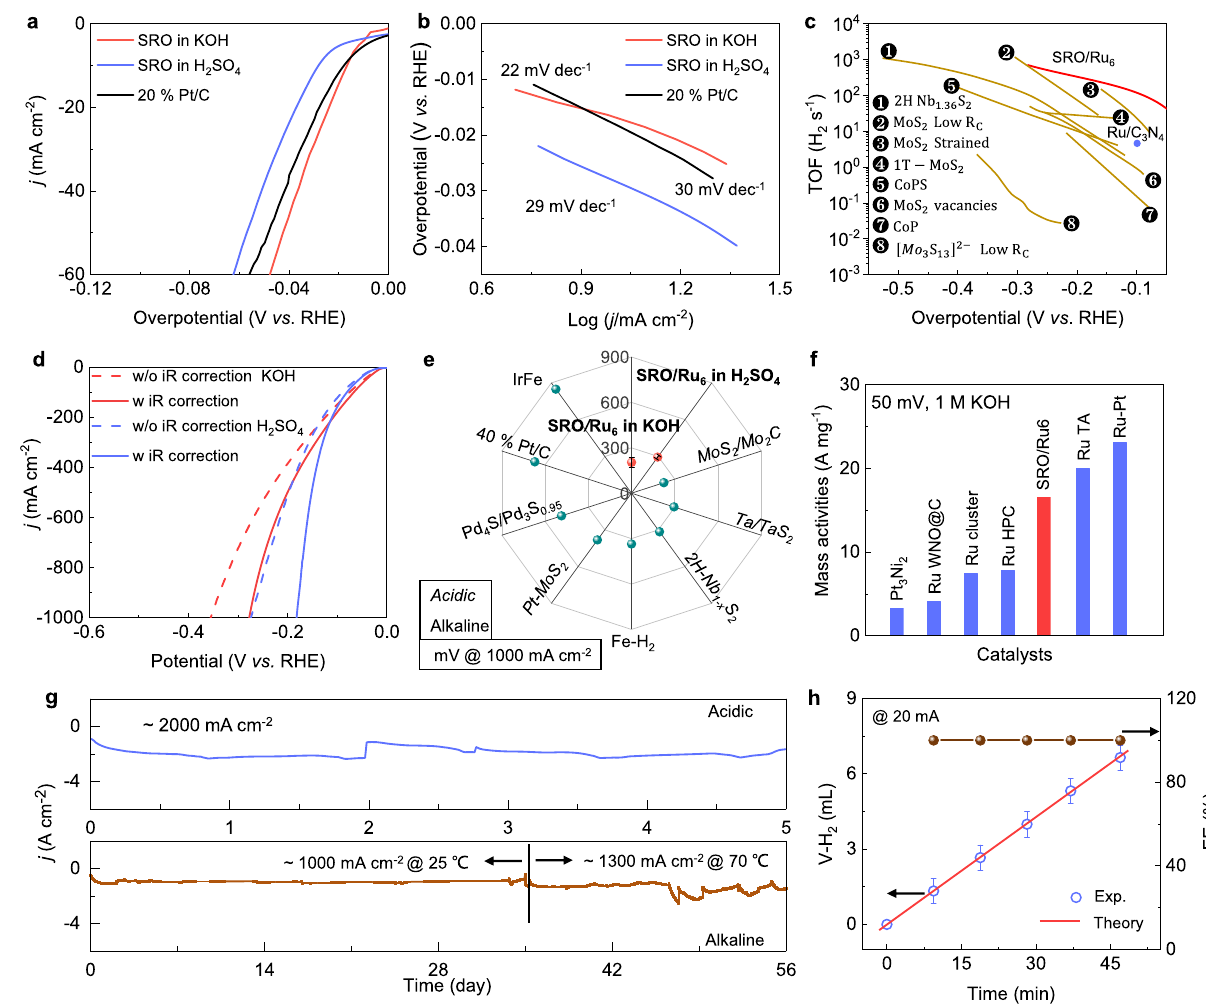
Fig. 2 | HER performance of SRO single crystal catalysts. a HER polarization curvesand b thecorrespondingTafelslopesofSROcatalystin0.5MH 2 SO 4 and1M KOH electrolytes. The LSV curve of Pt/C in 0.5M H 2 SO 4 is shown as a comparison. c Comparison of TOF values of the SRO catalysts with recently reported state-of- the-art catalysts. d LSV curves of the SRO catalyst plotted in a larger overpotential range with (w) and without (w/o) considering the ohmic drop. e Comparison of required overpotentials to reach the current density of1000mAcm − 2 betweenthe activated SRO catalyst and recently reported advanced catalysts. Scale bar of the